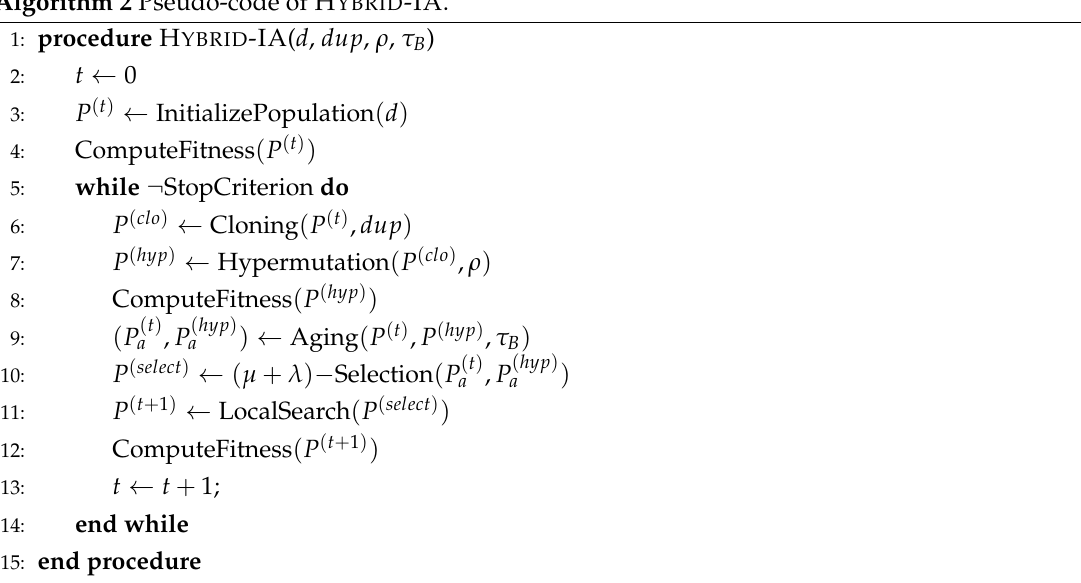
Algorithm 2 Pseudo-code of H YBRID